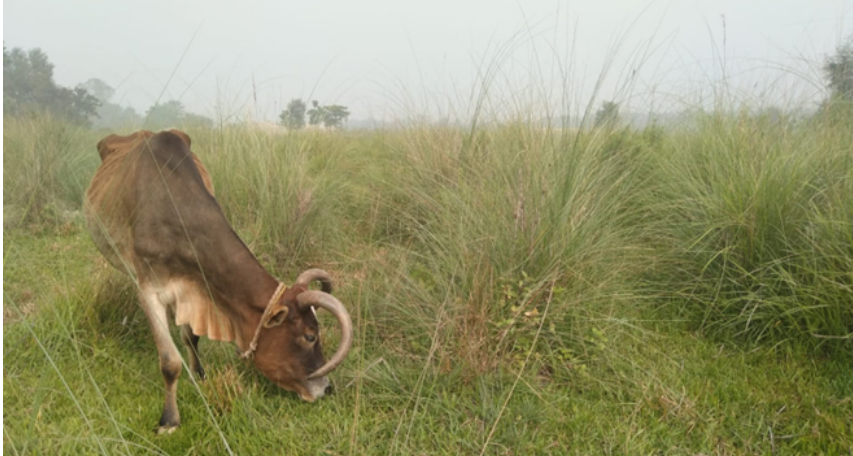
Figure A5. Grazing of cattle on the western bank of the Geruwa River at the southwestern border of study area. This image demonstrates the grazing pressure herbivores pose on the vegetation pattern at the border of the park both at present and in earlier times within the park when cattle grazing was allowed. The photograph was taken by the